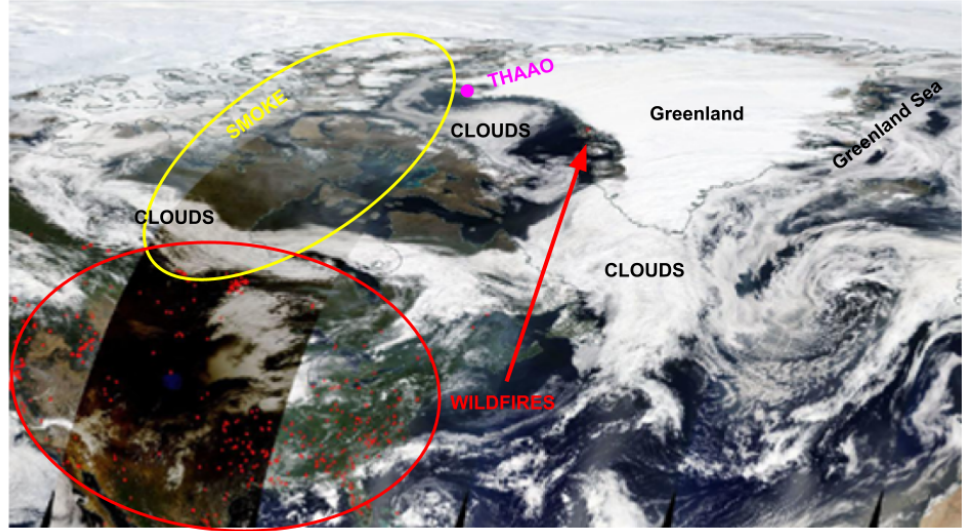
Figure 1. Terra-MODIS image for 24 August 2017. Red dots mark active fires individuated as “Fires and Thermal Anomalies”. Large fires were detected over Canada and smaller fires along the western coast of